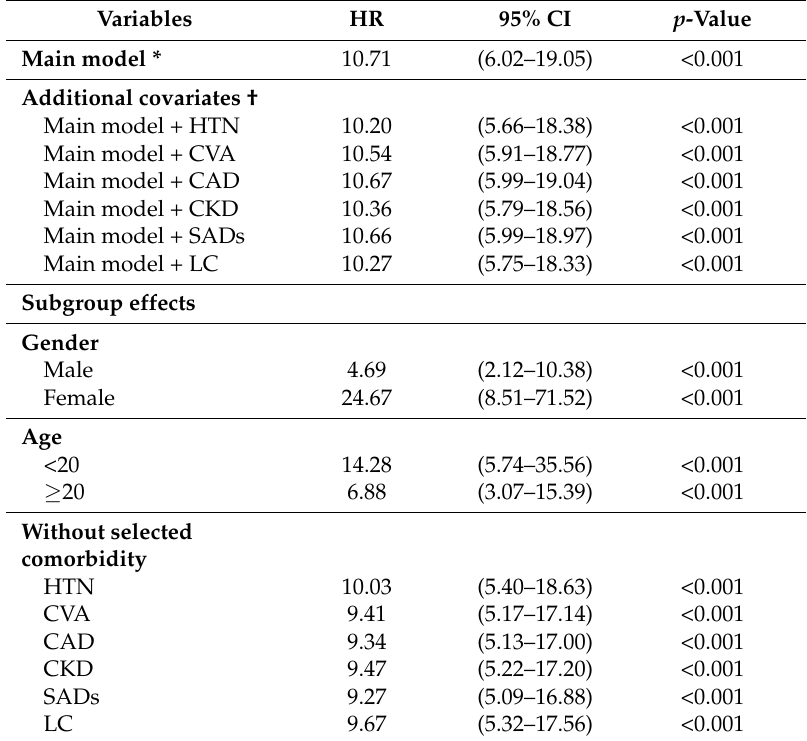
Figure 2. Cumulative incidence of DNI in the T1DM versus non-DM cohorts. Kaplan–Meier analysis demonstrated the cumulative DNI identified in the T1DM and non-DM cohorts during the 10-year follow-up period. The log-rank test revealed a significantly higher cumulative incidence in the T1DM cohort than in the non-DM cohort ( p < 0.001). Table 2. Multivariable Cox proportional hazards model for associations between DNI and T1DM.